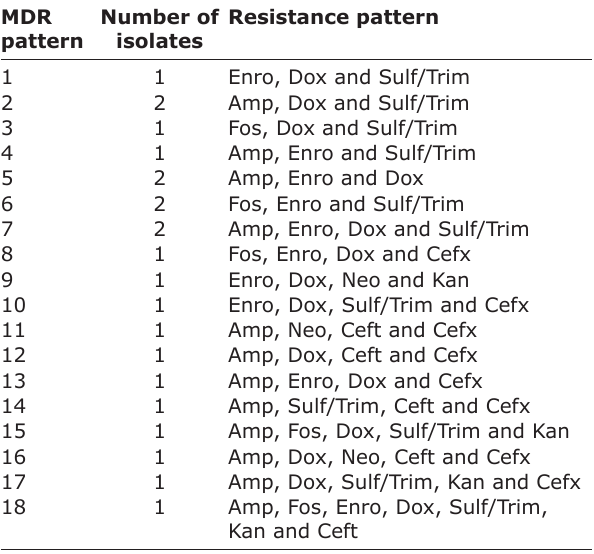
Table-2: Multiple drug resistance patterns of clinical Avian E. coli strains obtained from South Africa in 2016. MDR Number of Resistance pattern pattern isolates